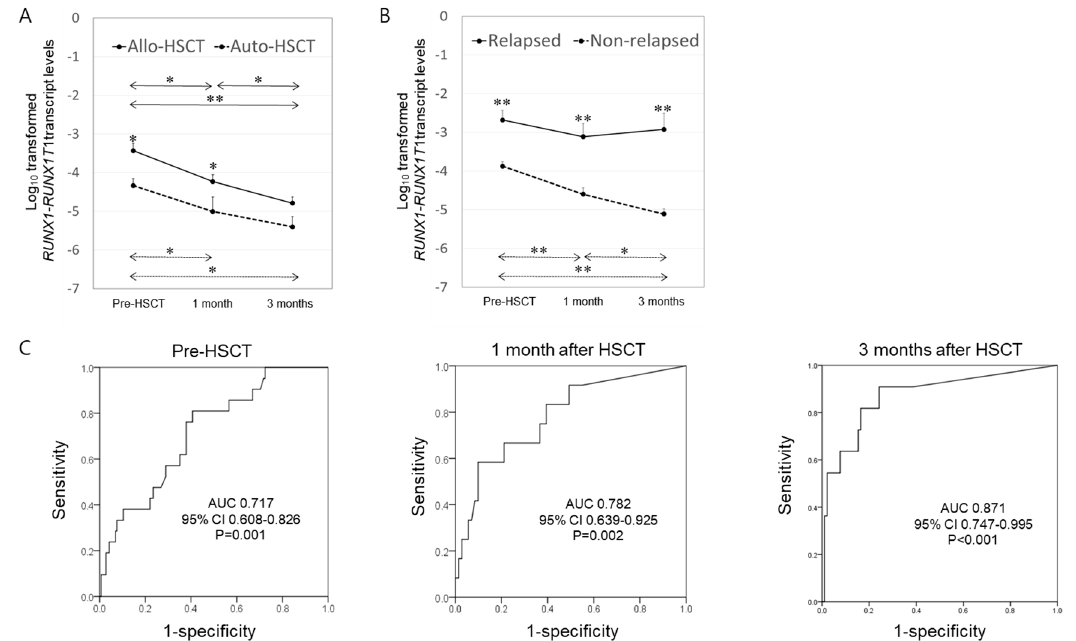
Figure 2. RUNX1–RUNX1T1 expression kinetics during peri-transplant period and optimal time points. ( A ) RUNX1–RUNX1T1 expression kinetics according to transplant type (Allo-HSCT vs. Auto-HSCT) before HSCT and at 1 or 3 months after HSCT (numbers of Allo-HSCT vs. Auto-HSCT; before, 112 vs. 54; 1 month, 70 vs. 13; 3 months, 86 vs. 16). ( B ) RUNX1–RUNX1T1 expression kinetics according to the occurrence of relapse (numbers of relapsed patients vs. non-relapsed patients; before, 21 vs. 145; 1 month, 12 vs. 71; 3 months, 11 vs. 91). ( C ) Receiver operating characteristic (ROC) curve analysis of RUNX1–RUNX1T1 levels at each time point. RUNX1–RUNX1T1 levels were normalized to the number of ABL1 transcripts and expressed as copy numbers per 10 5 copies of ABL1. Results are expressed as mean ± SEM. * p < 0.05, ** p < 0.01. AUC indicates area under curve.